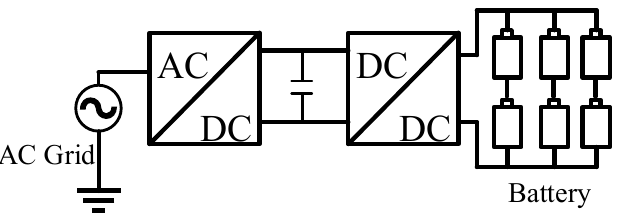
Figure 13. Structural diagram of single converter integrated systems.